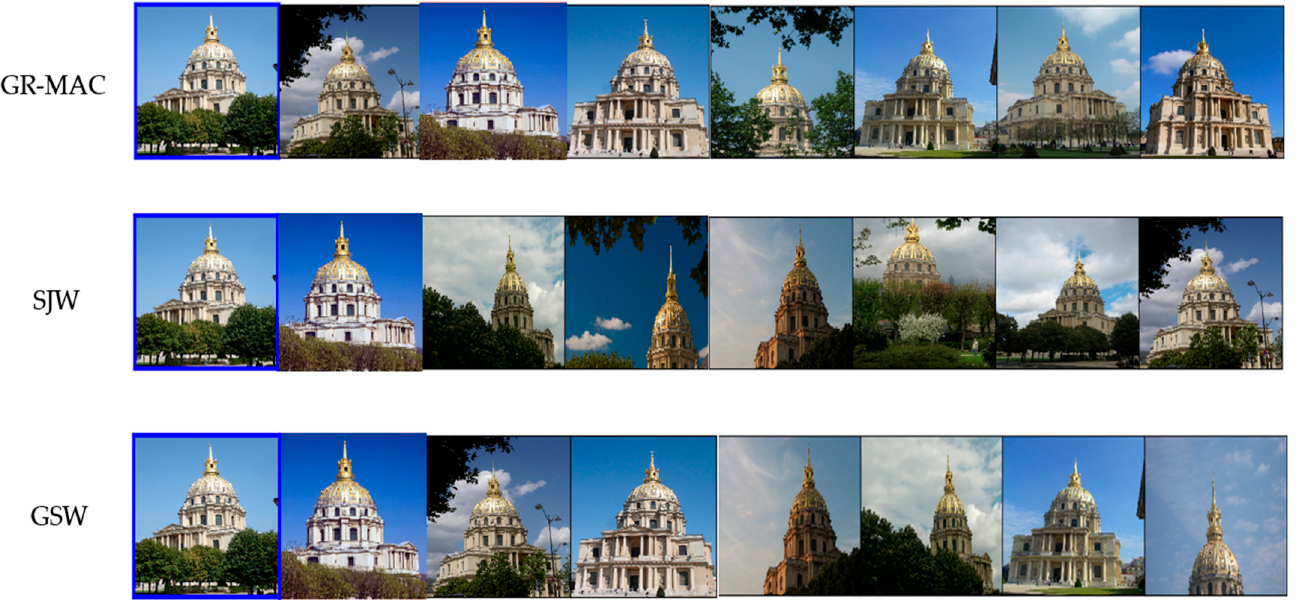
16 of 24 Figure 6. Saliency joint-weighted comparison heat map. SW, saliency weighted. The results of the experimental application of this retrieval result analysis procedure are provided to illustrate the proposed algorithm. As shown in Figure 7, the query image (the image in the blue box) corresponds to the return images of the module’s retrieval